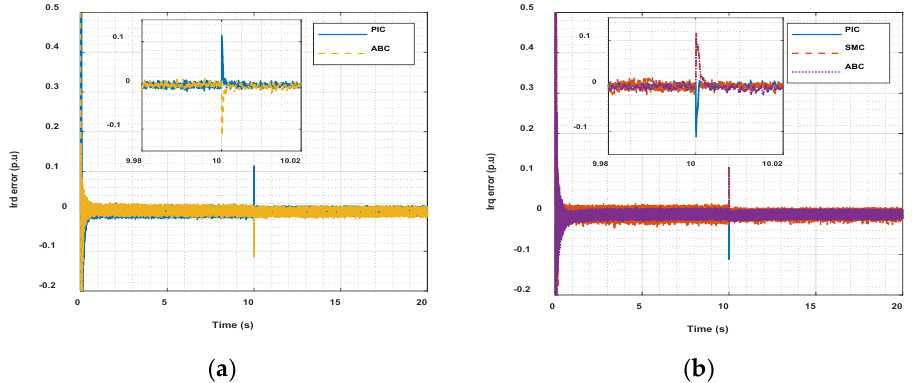
Figure 18. Rotor current error under 50% step increase in rotor and stator resistances, inductances, and mutual inductance; ( a ) Direct, ( b ) quadrature. Table 2. ITAE of PIC, SMC, and ABC errors.